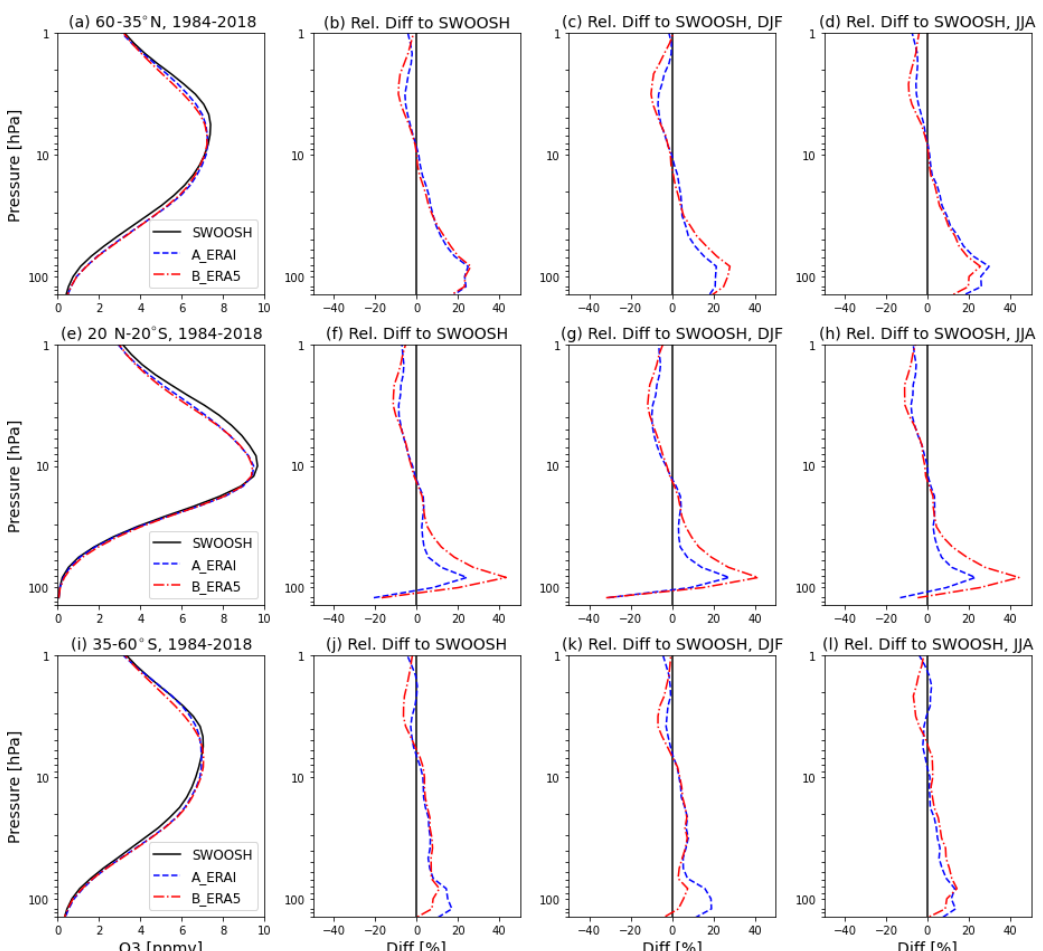
Figure 5. Averaged vertical ozone profiles from SWOOSH (black solid line), A_ERAI (blue dashed line), and B_ERA5 (red dash-dotted line) for (a–d) 60–35 ◦ N, (e–h) 20 ◦ N–20 ◦ S, and (i–l) 35–60 ◦ S (1984–2018). Relative differences (%) referencing each simulation to SWOOSH, which are averaged for the whole time period (1984–2018) for DJF and JJA seasons, are shown in the three right-hand columns for